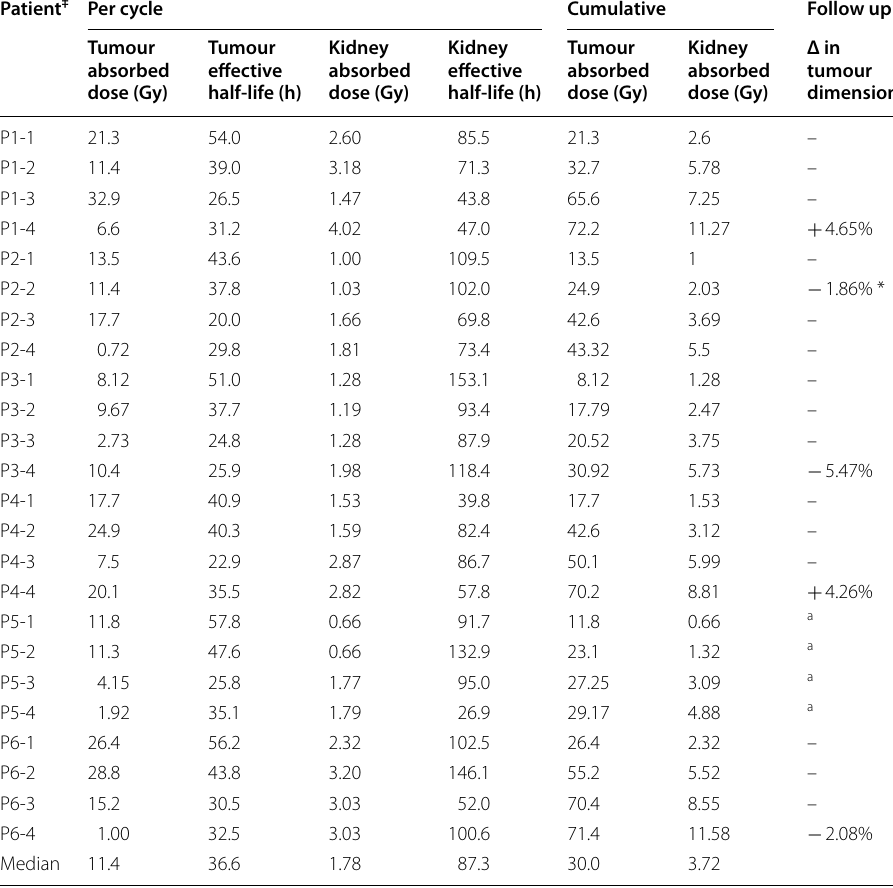
Table 2 Per cycle dosimetry, effective half-life and response one month after final cycle for all